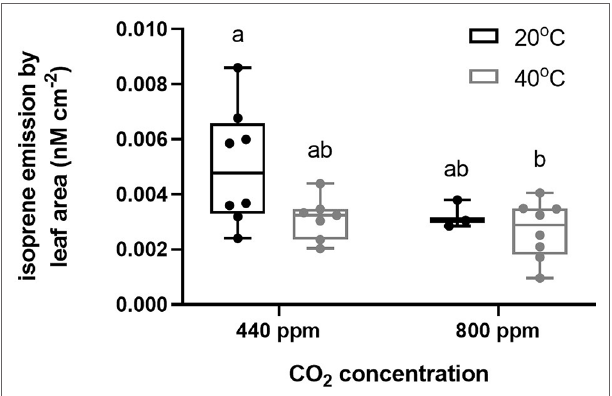
FIgURE 1 | Isoprene emission measurements by leaf area (nM cm −2 ) collected from air entrainment and analysed by GC-FID according to the CO 2 and temperature treatments (Hs, eCO 2 , Hs* eCO 2 , and control). Each data point represents one entrainment collection from each plant, and each box represents each treatment. Bars represent minimum and maximum values of the isoprene